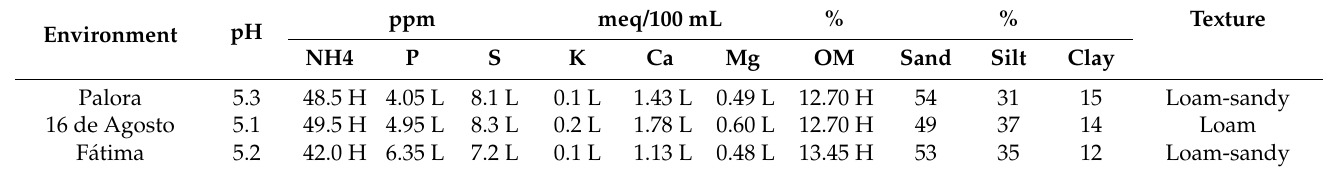
Table 1. Soil agrochemical